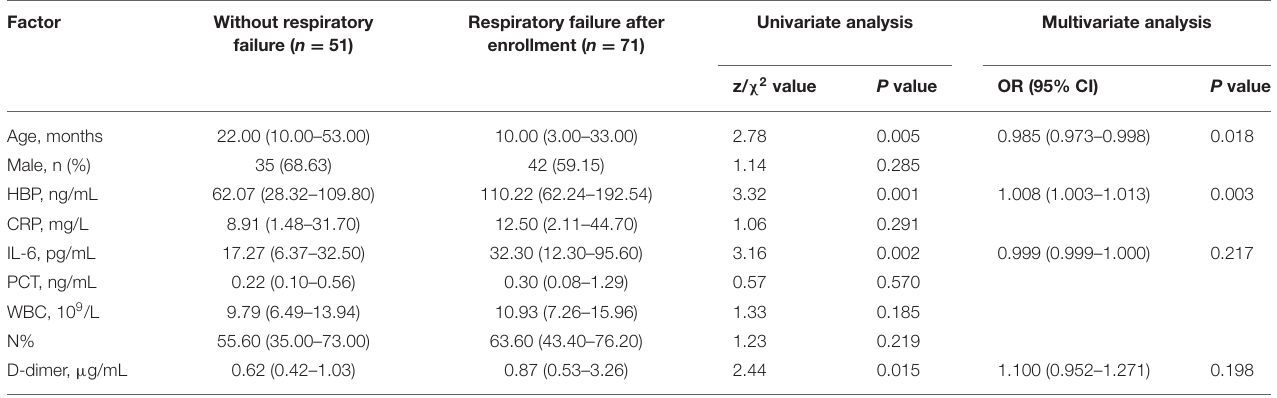
TABLE 2 | Univariate and multivariate analyses of respiratory failure in children with severe CAP. Factor Without respiratory Respiratory failure after Univariate analysis Multivariate analysis failure ( n = 51) enrollment ( n = 71)